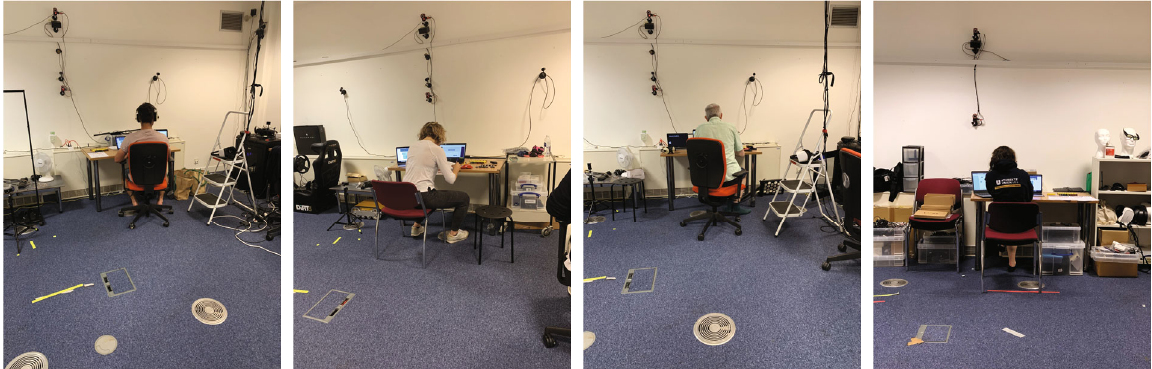
Figure 2: Participants using the questionnaires and the ASAD console.